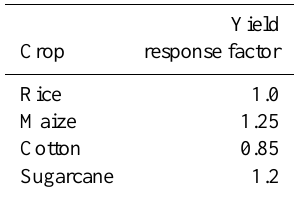
Table C1. Yield response factors for crops proposed for delta irri- gation schemes (based on Doorenbos and Kassam,